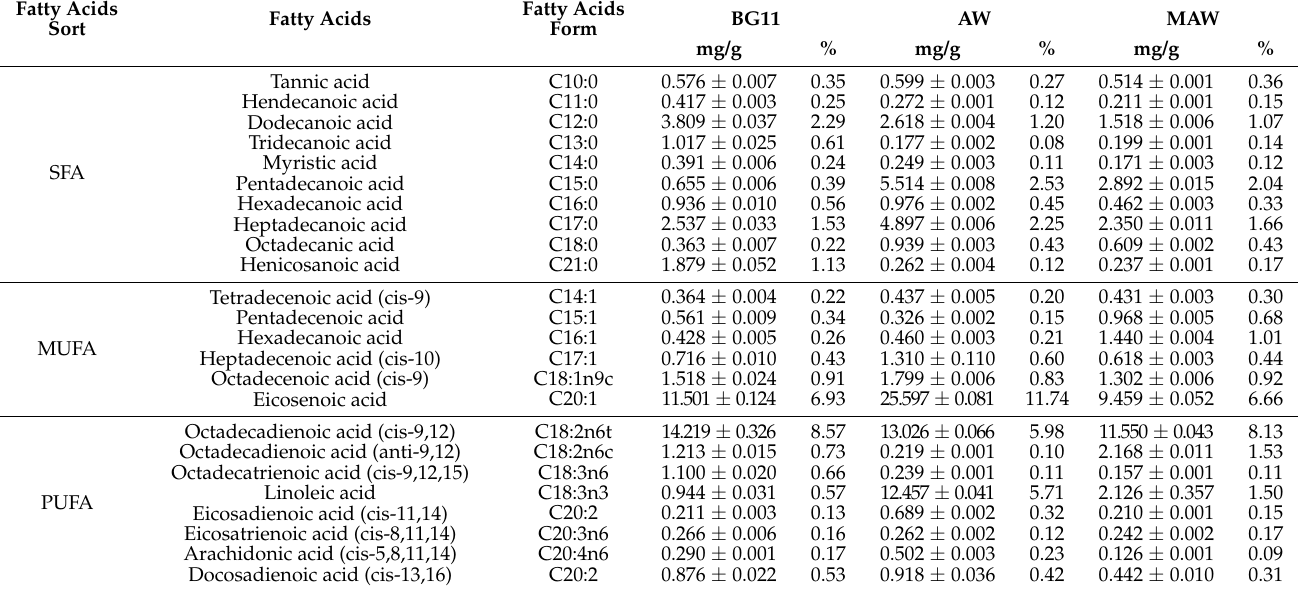
Table A3. Compositions of fatty acids, including saturated fatty acids (SFA), monounsaturated fatty acids (MUFA) and polyunsaturated fatty acids (PUFA), of microalgae cultivated in BG11, AW and MAW medium, respectively.